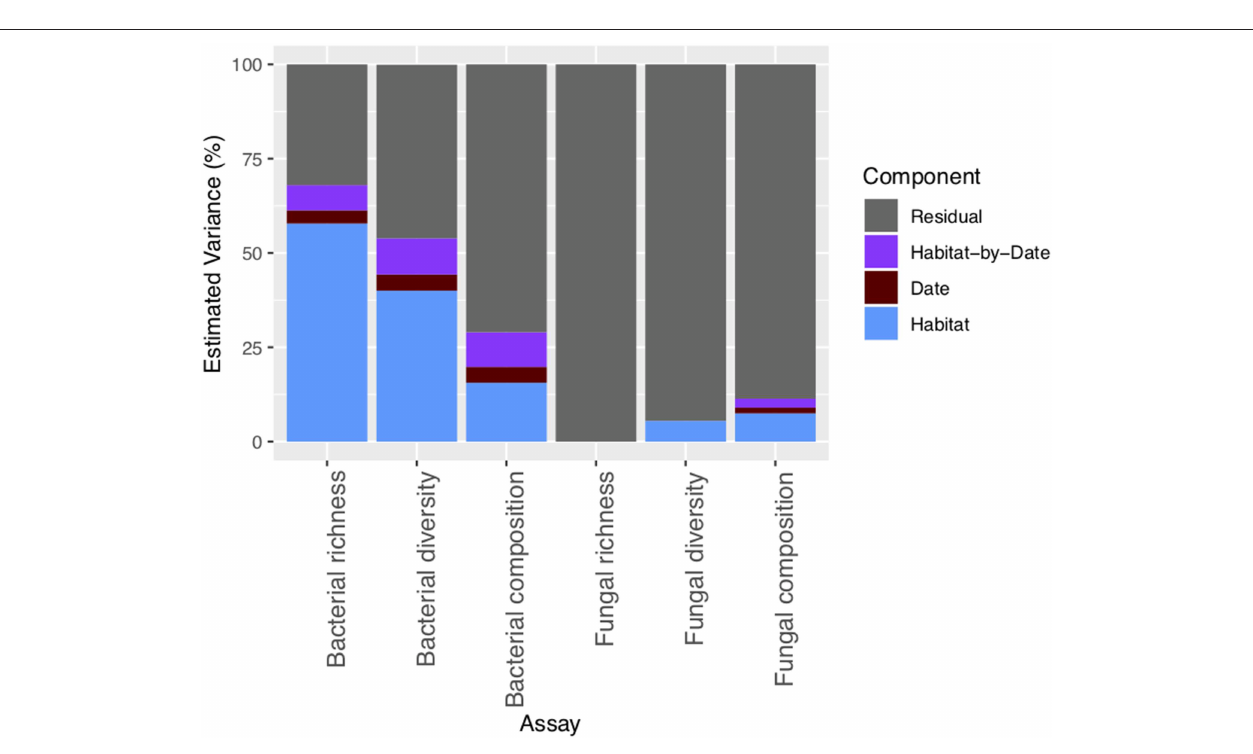
FIGURE 3 | Percentage of estimated variation across bacterial and fungal richness, diversity, and composition metrics explained by the microhabitat, date, and